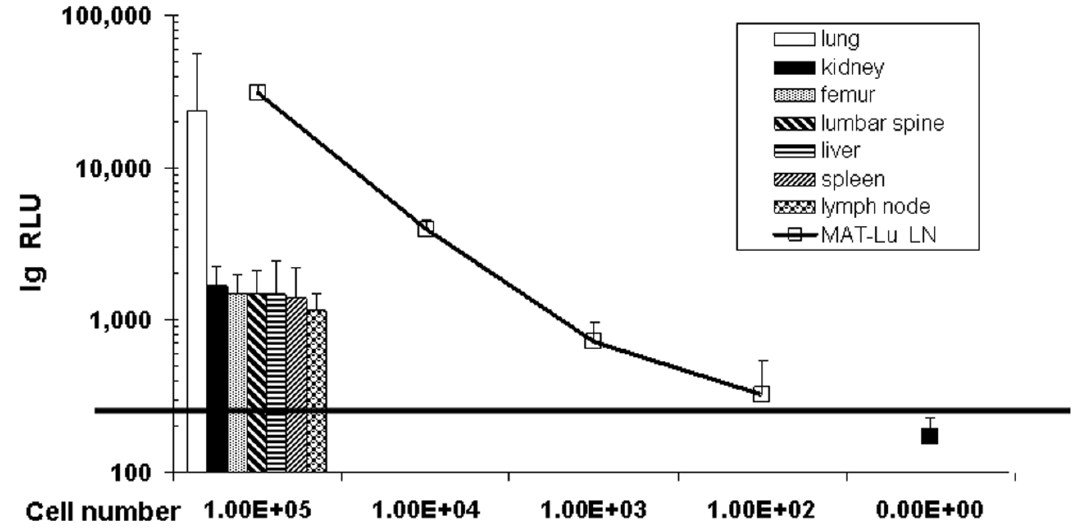
Figure 2. Metastatic burden in different rat tissues compared to luciferase activity in MAT-Lu ELN cells. Metastatic burden in individual tissues was determined by homogenization and subsequent luciferase assay. Metastases appear in lung, lymph nodes, spleen, kidney, liver, and bone tissue (femur or lumbar spine) of untreated animals (columns). The metastatic burden in respective tissues (columns) is shown at the y-axis as mean RLU (relative light unit) values of tissues from metastatic animals. Corresponding cell numbers were calculated by a standard curve of crude lysates from defined numbers of MAT-Lu ELN cells (□) numbered on the x-axis. The black horizontal line marks the detection limit for metastatic lesions in individual tissues which was about 100 cells per tissue piece when defined as ≥ 1.6 times of the background value